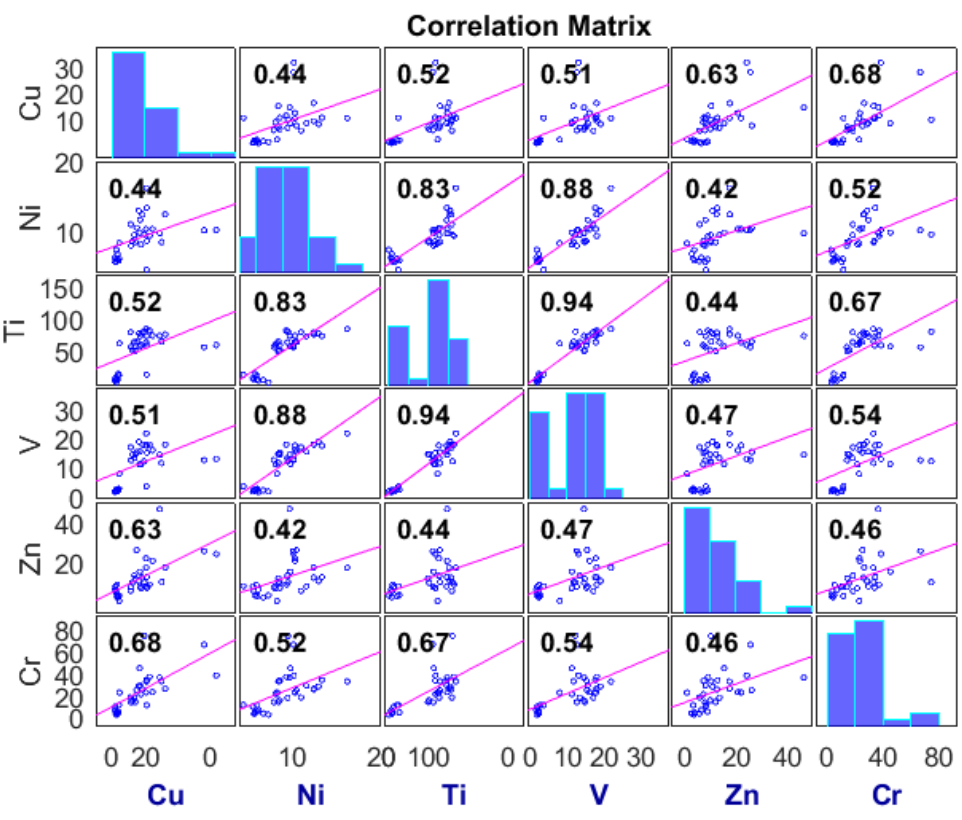
Figure 5. Feature selection of the variables based on the Spearman–Pearson-based correlation technique.